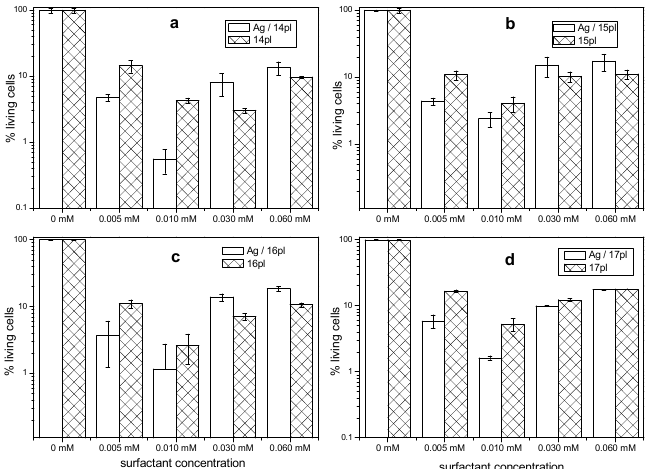
Figure 9. Cytotoxicity of alkylidimethylphenylphospholium surfactant-stabilized silver nanoparticles ( a : Ag/ 14pl , b : Ag/ 15pl , c : Ag/ 16pl , and d : Ag/ 17pl ) and of silver-free surfactant solutions ( a : 14pl , b : 15pl , c : 16pl , and d : 17pl ) at four different surfactant concentrations. Cell viability of 100% represents no cytotoxic effect on cancer cells.